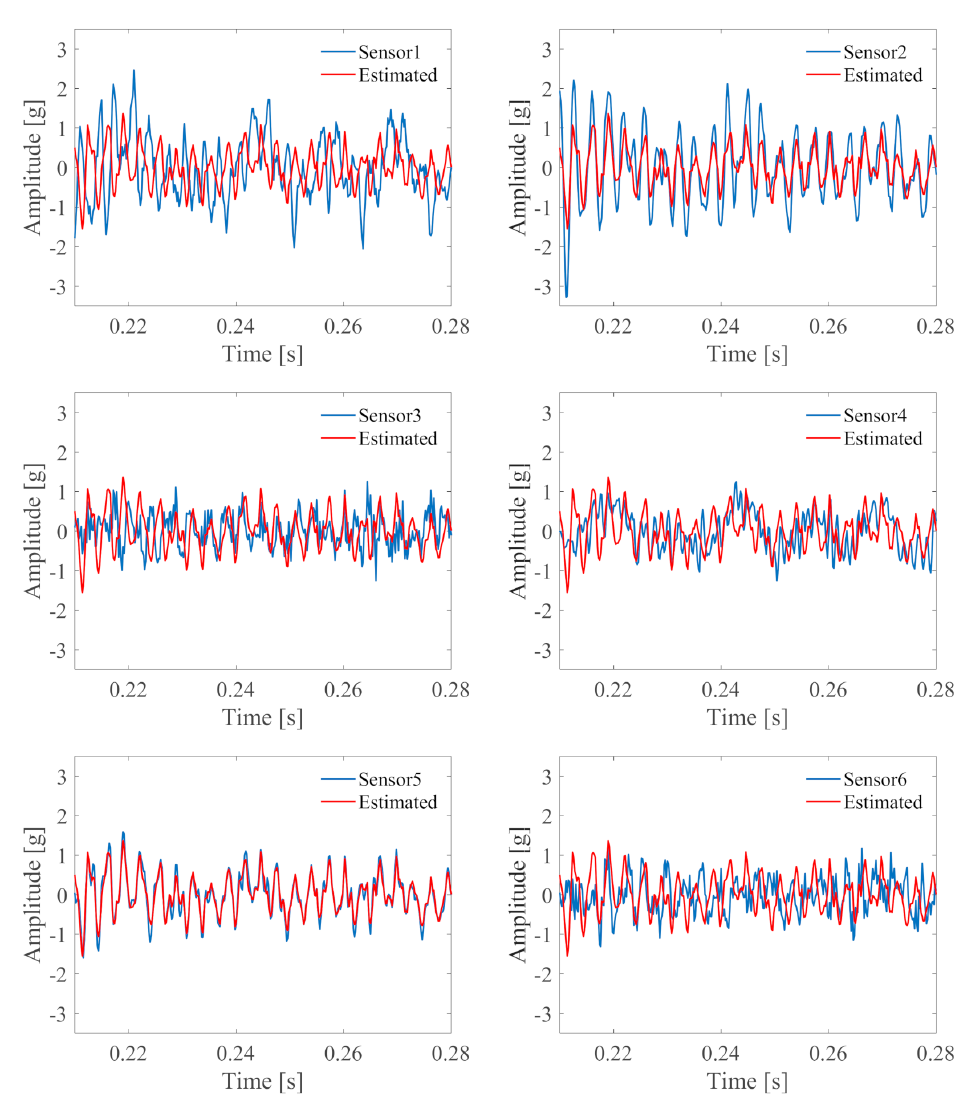
Figure 16. Contrasted results zoomed in 0.21–0.28 s in inner race fault